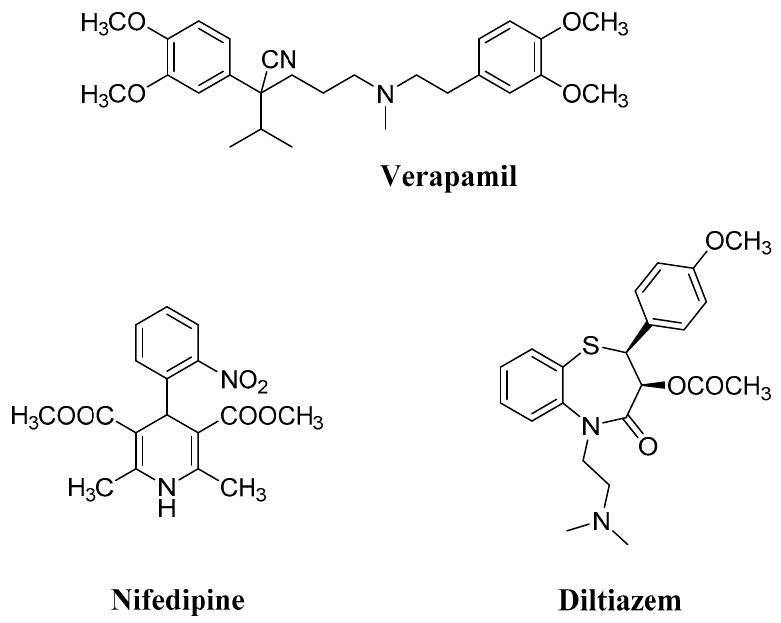
Figure 1. Prototypes of the main classes of calcium channel blockers (CCBs).